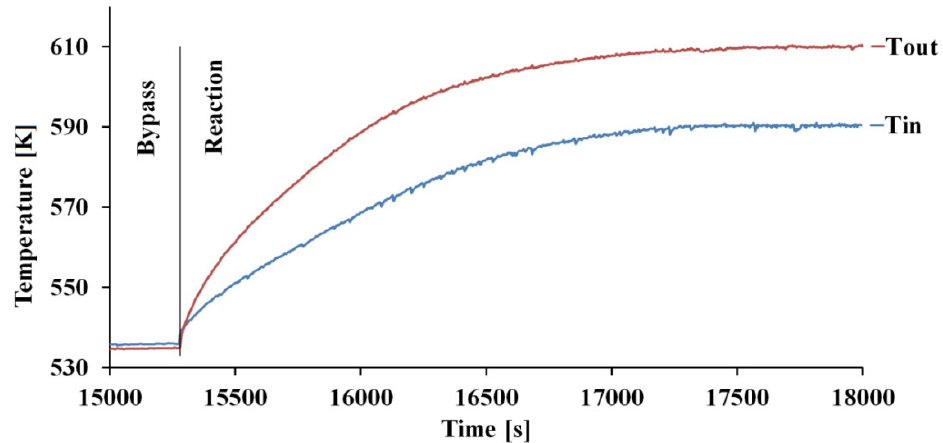
Figure 5. Evolution of the temperature profiles at the inlet and at the outlet of the catalytic bed during the experiment with PtCeWF10.